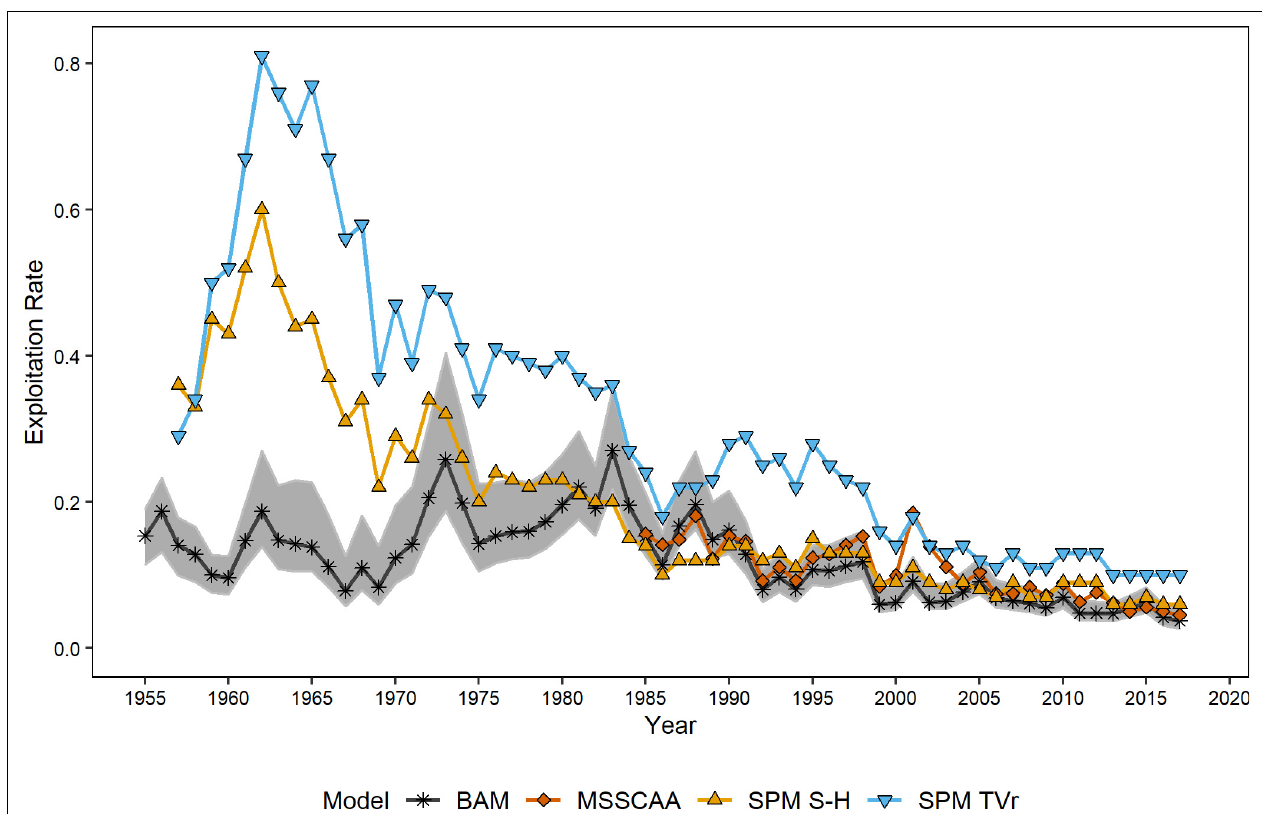
FIGURE 2 | Estimates of exploitation rates from the ERP and single-species models. Shaded area indicates 95% confidence intervals from the single species assessment model. TABLE 4 | Spearman’s rank correlation coefficients and p -values between estimates of exploitation rate across models.